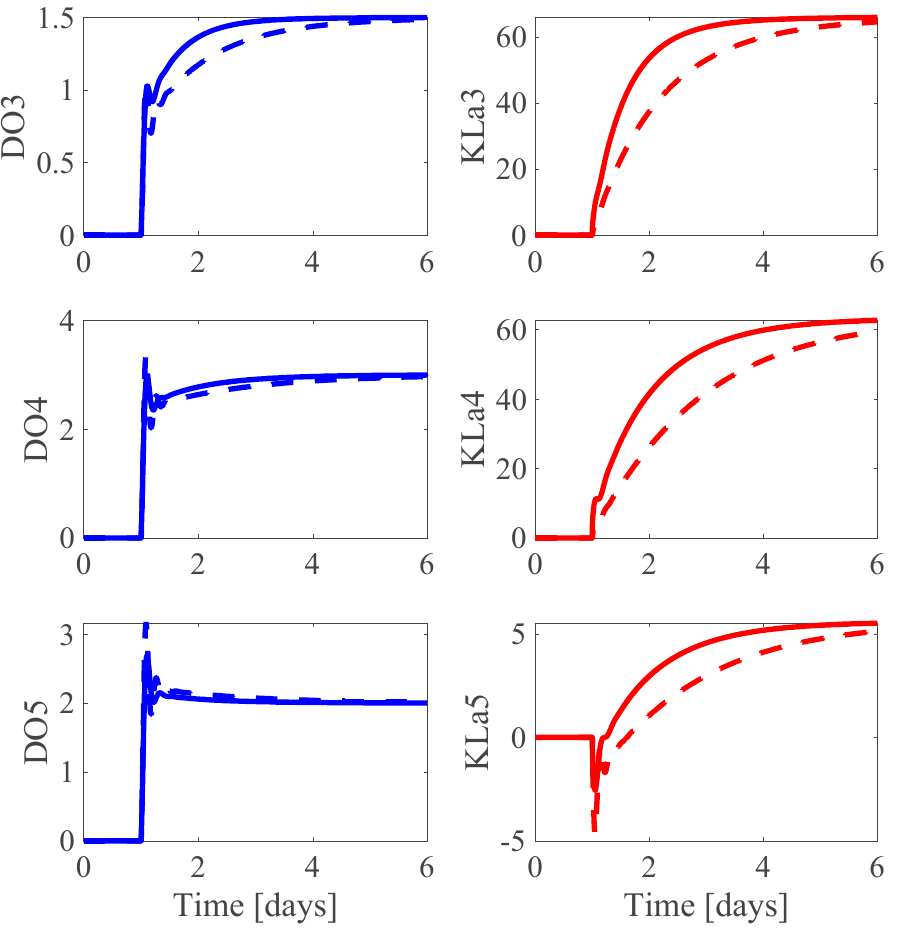
Figure 2. Time response of the selected PI controller (solid line) and the PI reference controller (dashed